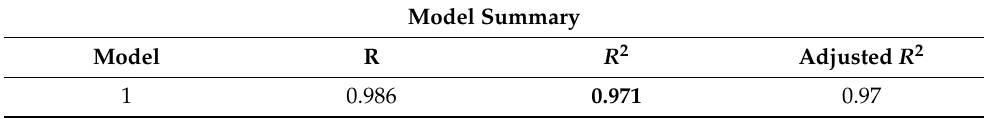
Table 6. Results showing independent variables explanation of the dependent variable.